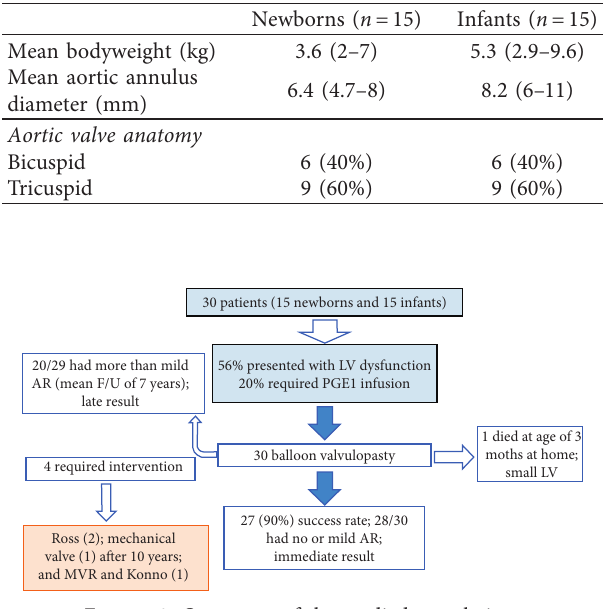
Figure 3: Outcomes of the studied